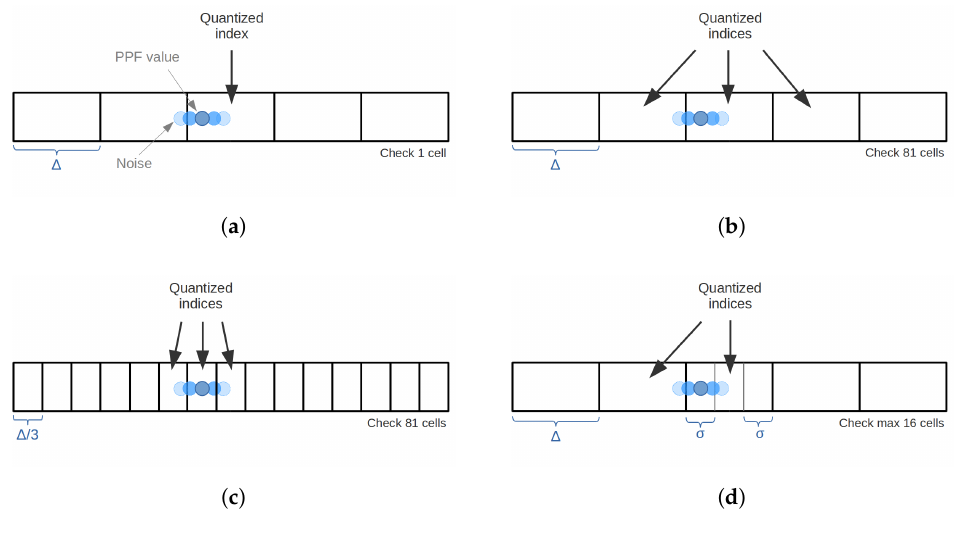
Figure 7. One-dimensional example of the noise effect on the lookup table during matching with four different strategies. ( a ) original approach; ( b ) approach of [26] using ∆ ; ( c ) approach of [26] ∆ using ; ( d ) our 3